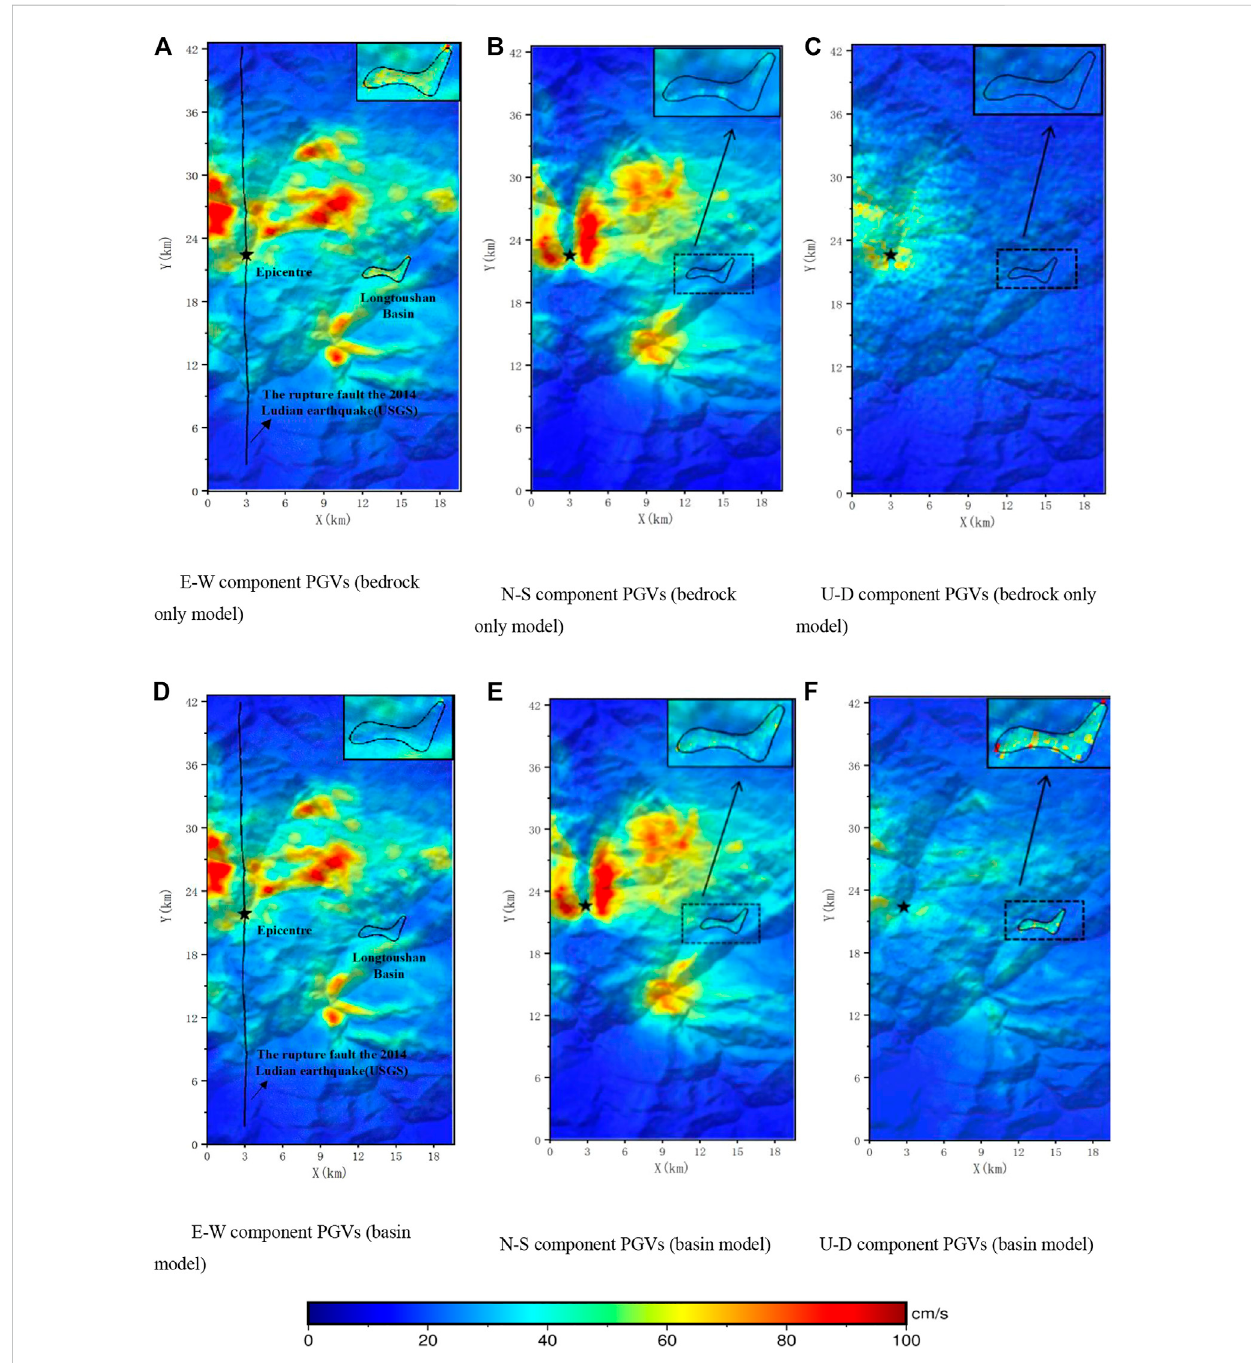
FIGURE 9 PGV (m/s) distribution of E – W, N – S, and U-D components obtained using different models. The black star and black line denote the epicenter and rupture fault of this earthquake provided by the USGS, respectively. (A) E-W component PGVs (bedrock only model). (B) N-S component PGVs (bedrock only model). (C) U-D component PGVs (bedrock only model). (D) E-W component PGVs (basin model). (E) N-S component PGVs (basin model). (F) U-D component PGVs (basin